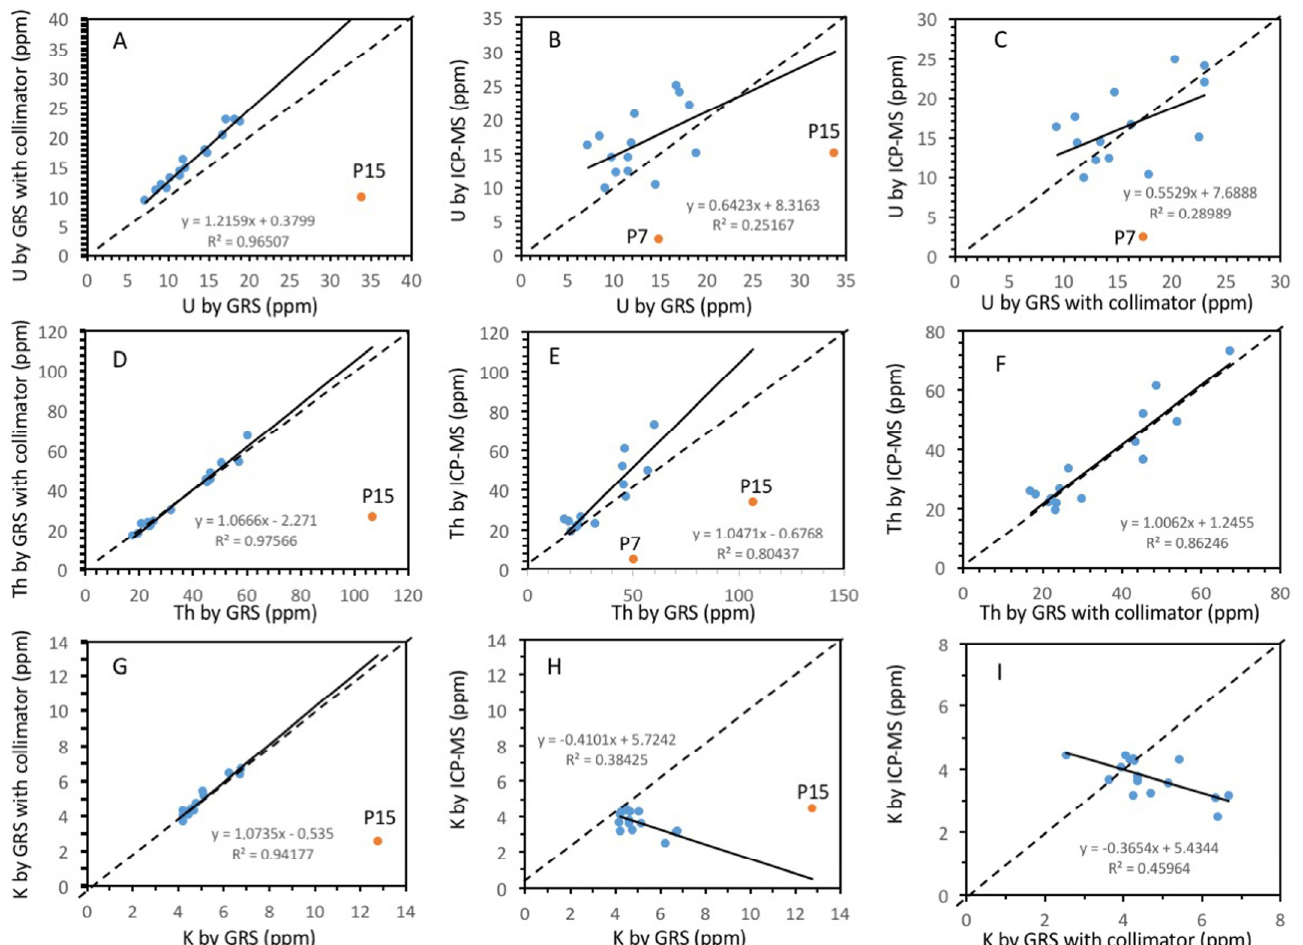
Figure 2. Estimated contents of the different studied elements with geochemical analyses and GRS: ( A , D , G ) estimated contents obtained by GRS without vs. with collimator; ( B , E , H ) estimated contents obtained by GRS without collimator vs. geochemical analyses (XRF + ICP-MS); ( C , F , I ) estimated contents obtained by GRS with collimator vs. geochemical analyses (XRF + ICP-MS).